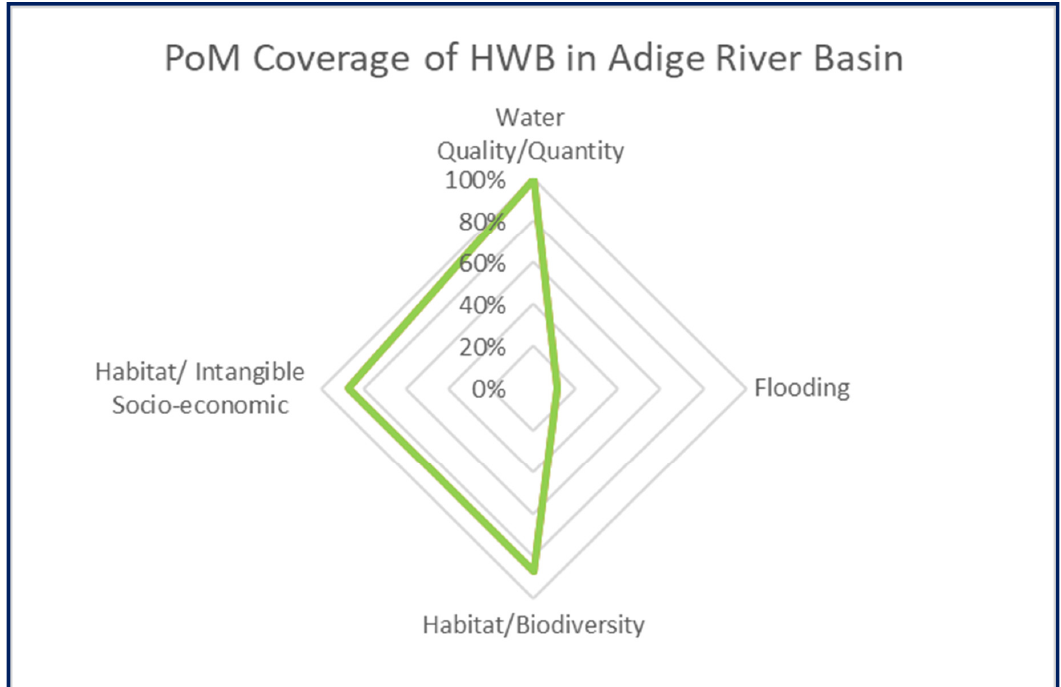
Figure 5. The coverage of HWB factors within the Adige River Basin.